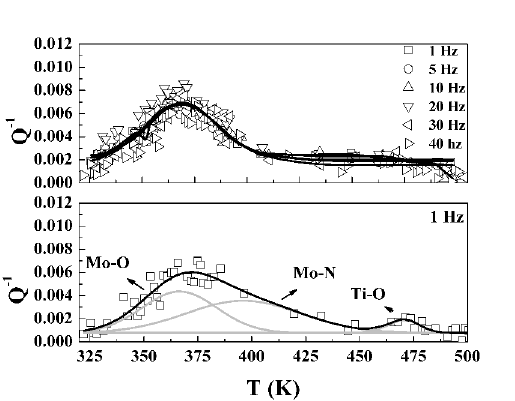
Figure 4. Peak decomposition of the Ti-15Zr-20Mo alloy at low temperatures.